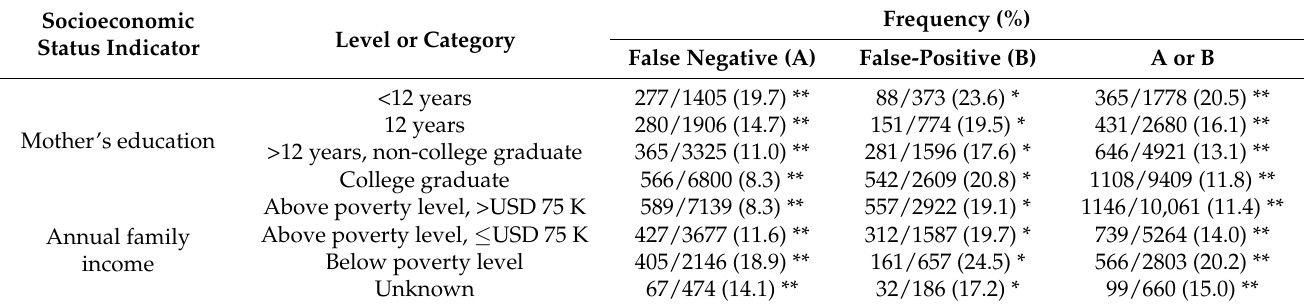
Table 2. The false-negative and false-positive cases of the parent-reported responses (Method 1) against the provider-reported vaccination records (Method 2) at each level of socioeconomic status in Subsample A (N =